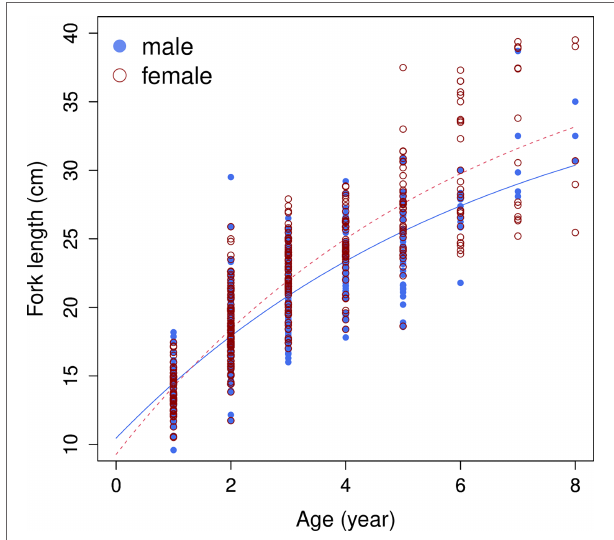
FIGURE 7 | Growth curves of von Bertalanffy growth model (VBGM), by sex, for brushtooth lizardfish off